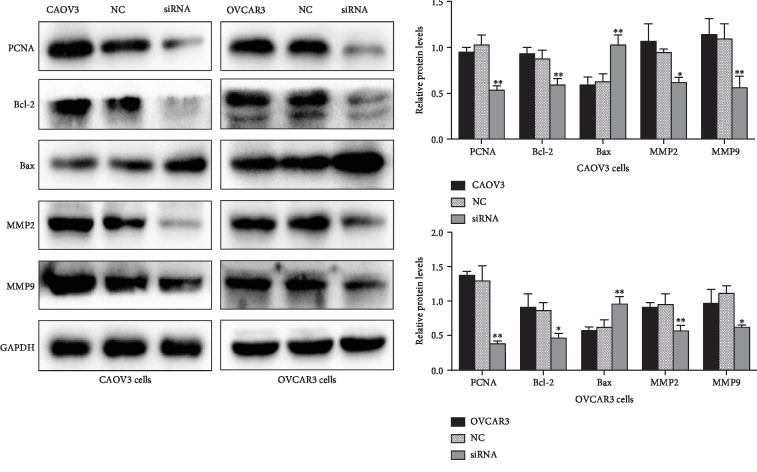
Changes in the expression of PCNA, Bax, Bcl-2, MMP2, and MMP9 in CAOV3 and OVCAR3 cells after transfection of BMPER siRNA. Western blot showed knock down of BMPER gene by siRNA reduced the expressions of PCNA, Bcl-2, MMP2, and MMP9, while the level of proapoptotic protein Bax was increased after that. GAPDH was used as the internal control. Compared with the control group, ∗P < 0.05, ∗∗P < 0.01.